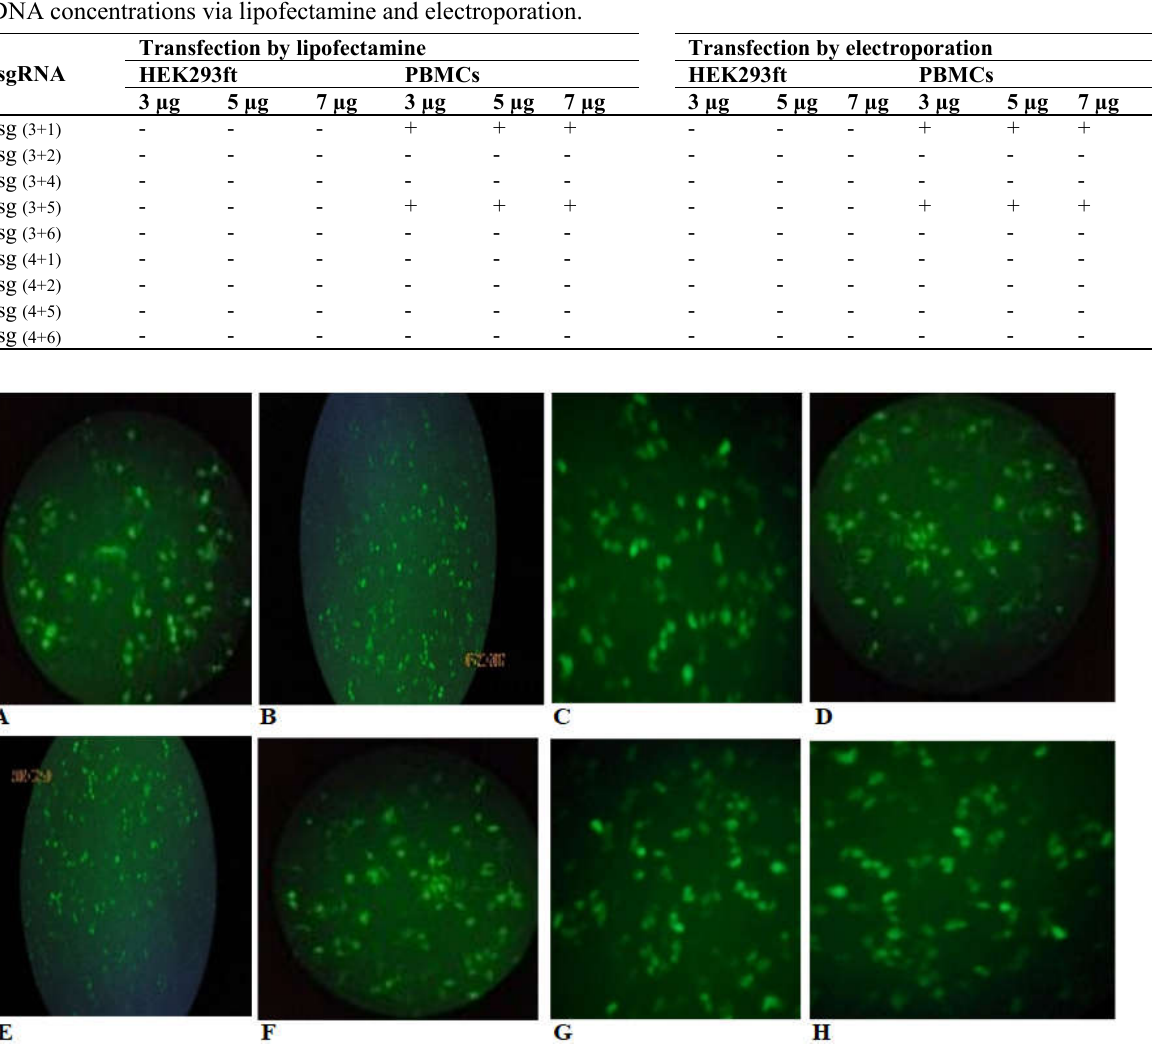
Fig. 2. GFP expression. Transfection by lipofectamine and electroporation in HEK293 & PBMCs: A) Sg (3+1), B) Sg (3+2); C) Sg (3+5); D) Sg (3+6); E) Sg (4+1); F) Sg (4+2); G) Sg (4+5); H) Sg (4+6); Almost 75% of cells were transfected. (Fluorescent imaging. Scale: